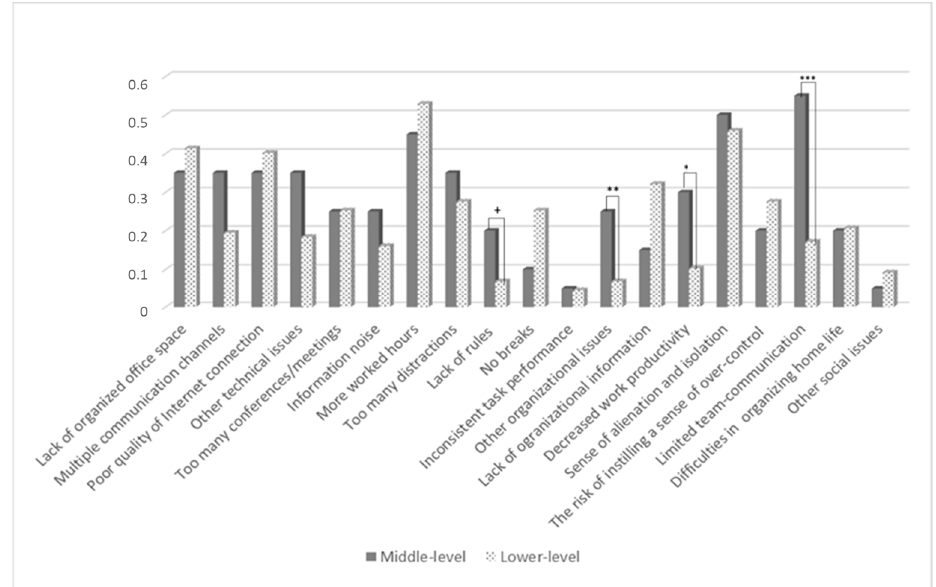
Figure 2. Remote work limitations, perceived by lower- and middle-level managers. Notes. * p < 0.05; ** p < 0.01; *** p < 0.001; + p < 0.10.